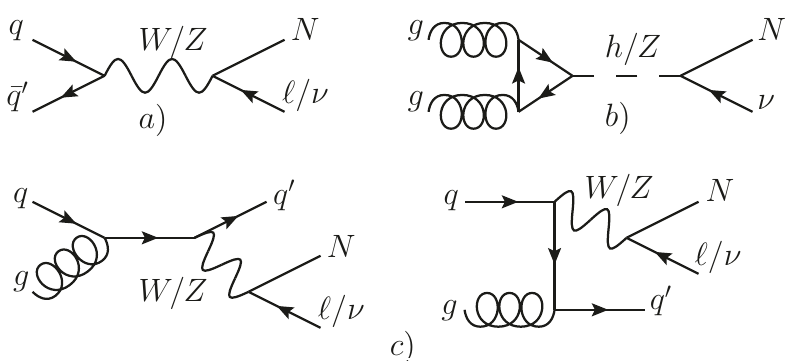
Figure 7 . HNL production channels: a) Drell-Yan-type process; b) gluon fusion; c) quark- gluon fusion.